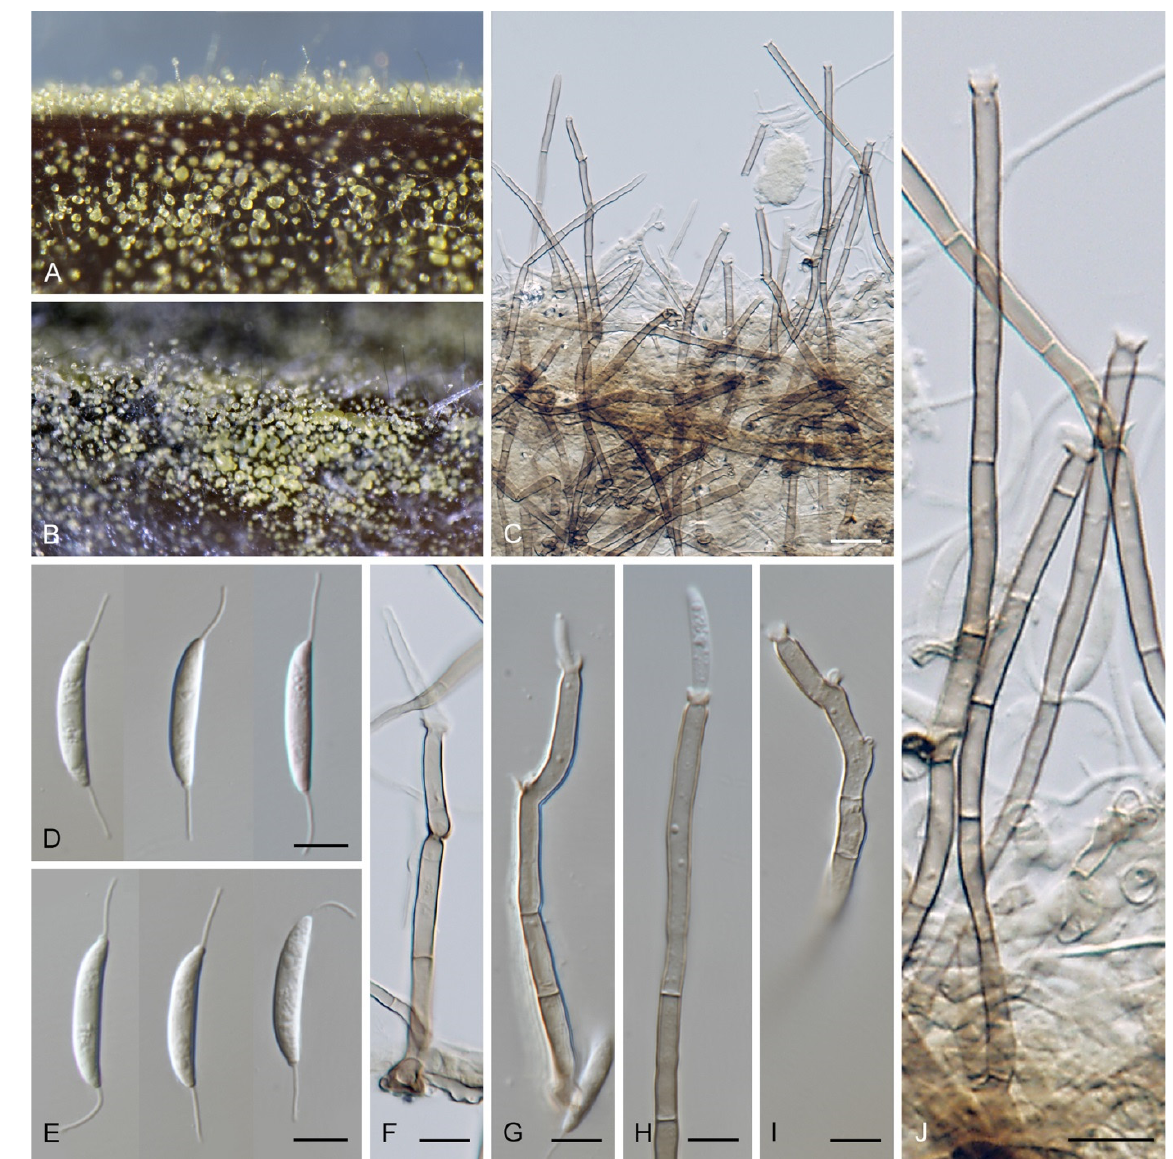
Figure 26. Codinaeella mimusopis (CBS 143435 ex-type). ( A , B ) Colonies ( C , F – J ) conidiophores ( D , E ) conidia. Images: ( A ) on a pine needle on SNA after 8 weeks ( B ) on a stem of U. dioica on CMA after 8 weeks. Scale bars: ( C , F – I ) 20 μ m; ( D , E ) 5 μ m; ( J ) 10 μ m.